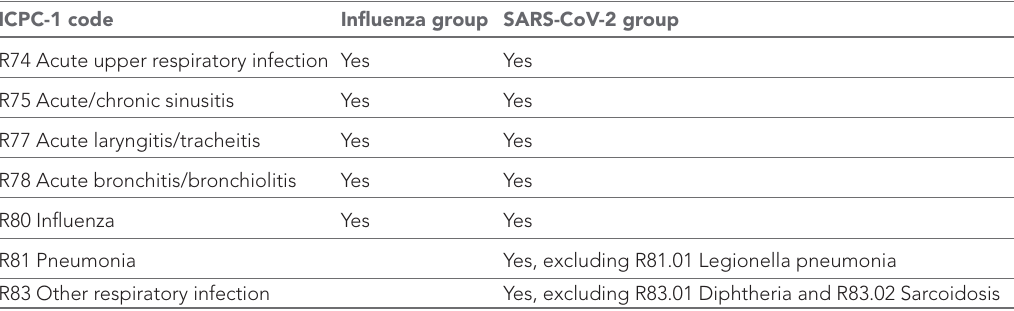
Table 1 Overview of included ICPC- 1 codes per